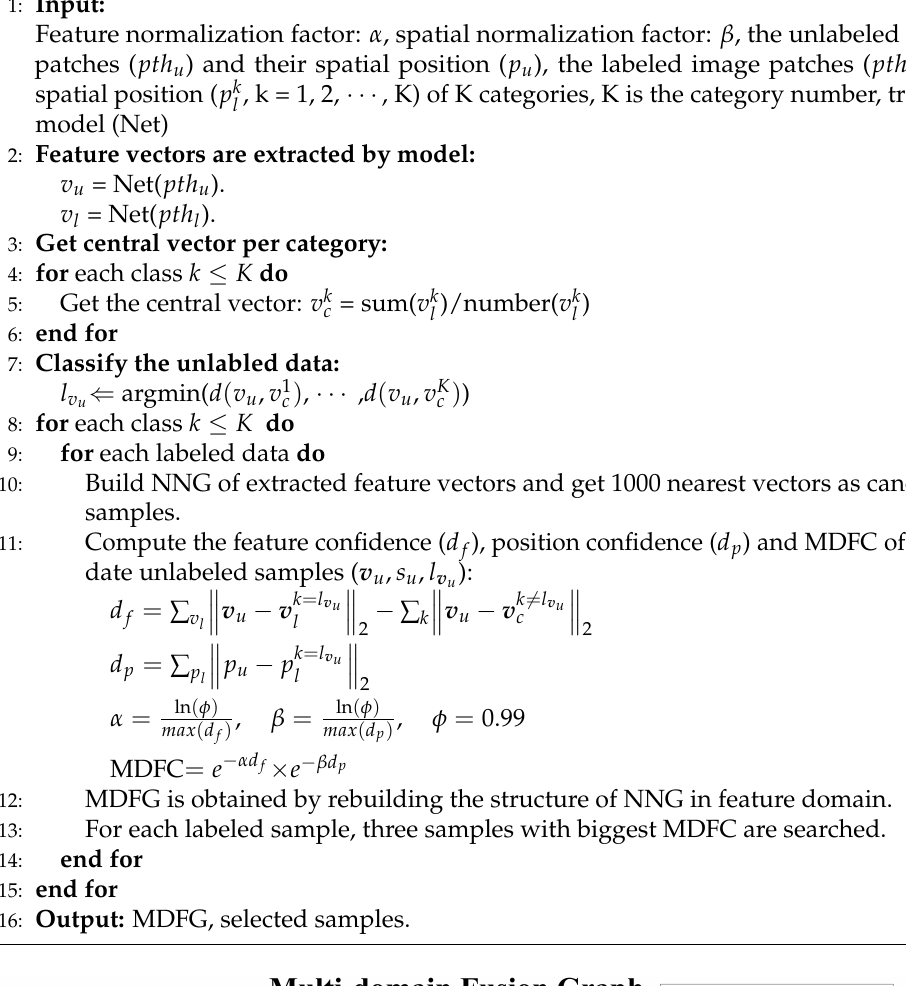
Algorithm 1 MDFG algorithm